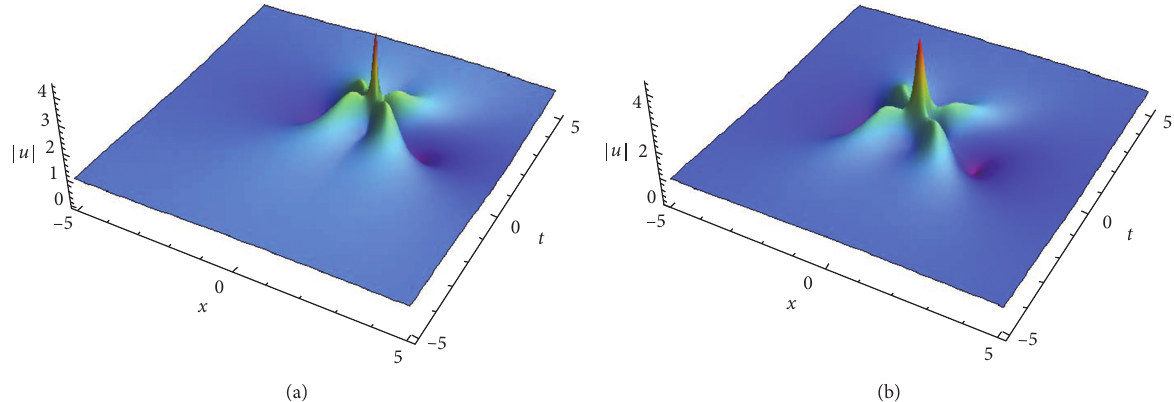
Figure 6: Second-order fractional rogue wave solution (color online) (39) and its comparison with the integer order. (a) α � 9/7 and a � 1; (b) α � 1 and a �